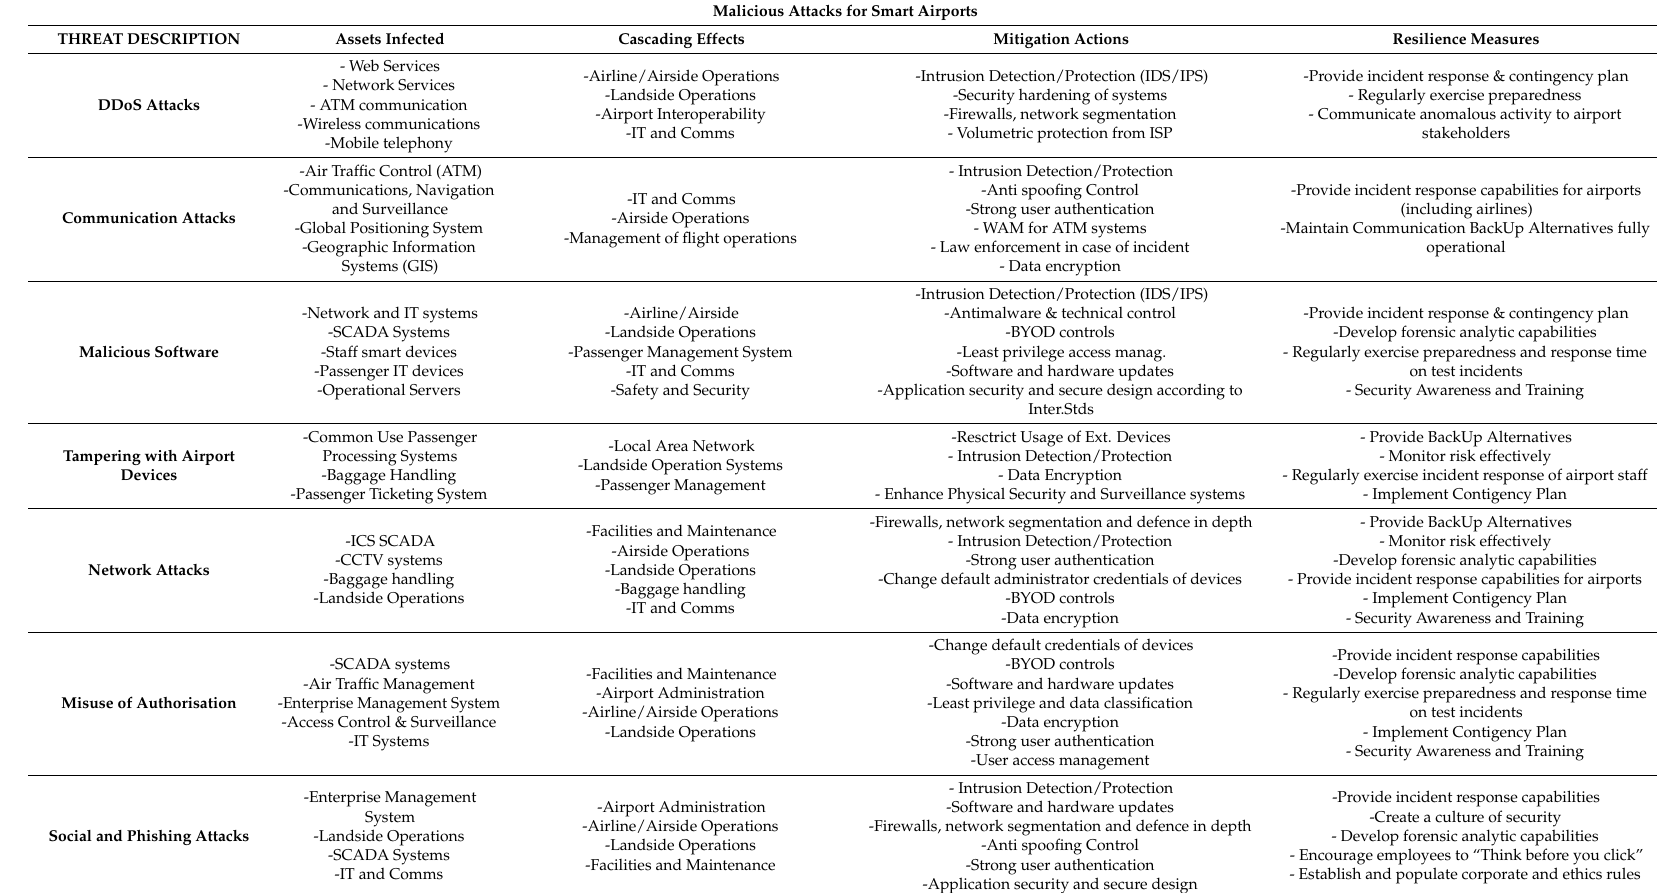
Table 1. Smart Airport’s malicious attack aggregate